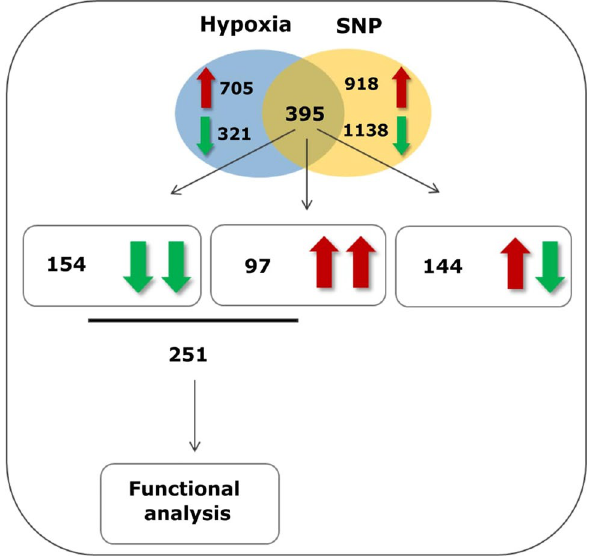
Figure 2. Venn diagram of common differentially expressed genes (DEGs) (Padj < 0.05) under both hypoxia and SNP-treatment. Red and green arrows represent down- and up-regulated genes, respectively. Boxes containing double green and double red arrows indicates number of down (154)- and up-regulated (97) DEGs under both hypoxia and SNP-treatments. The box containing both red and green arrows indicates the number of DEGs (144) with opposite regulation in response to hypoxia and